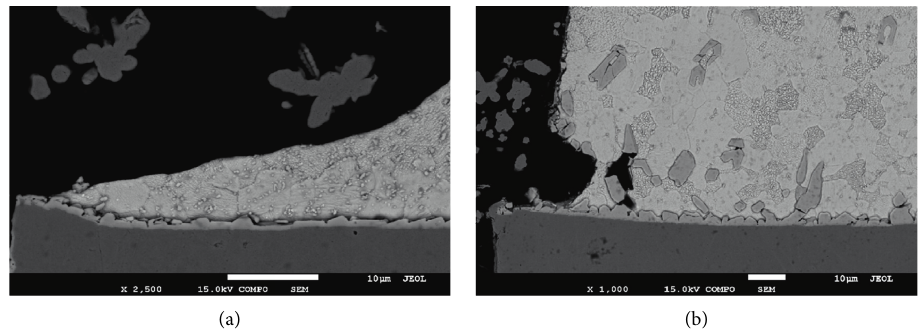
Figure 11: Microstructure of the SAC158 (a) and SAC357joints (b) soldered by induction heating.